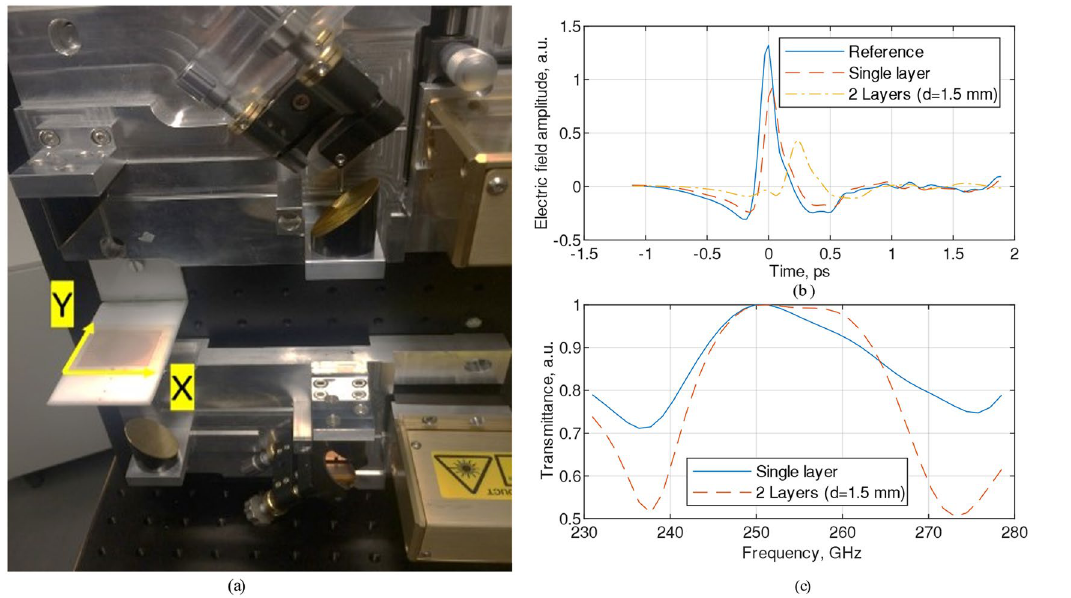
Figure 7. ( a ) TeraPulse 4000 Spectroscopy system for measuring FSS filter, measured and normalized ( b ) measured pulse response of electric field amplitude where the refence signal was measured without the FSS layer and ( c ) measured signal transmittance of single- and double-layer unit